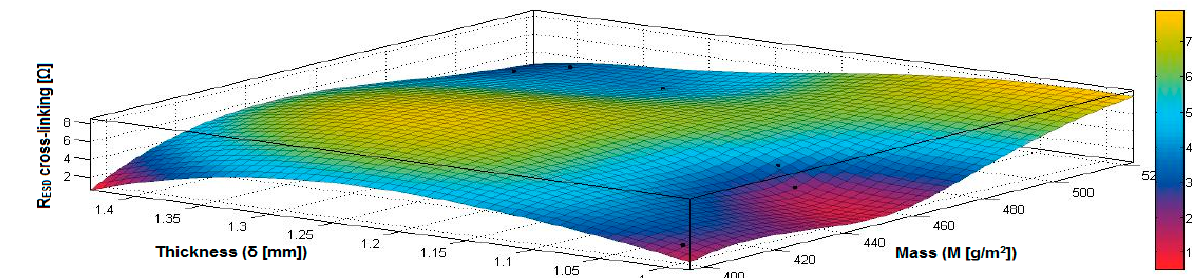
Figure 38. 3D representation R ESD after crosslinking = f(M, δ ) samples preliminarily treated in RF plasma O 2 using RF 2 generator and power 50 W.